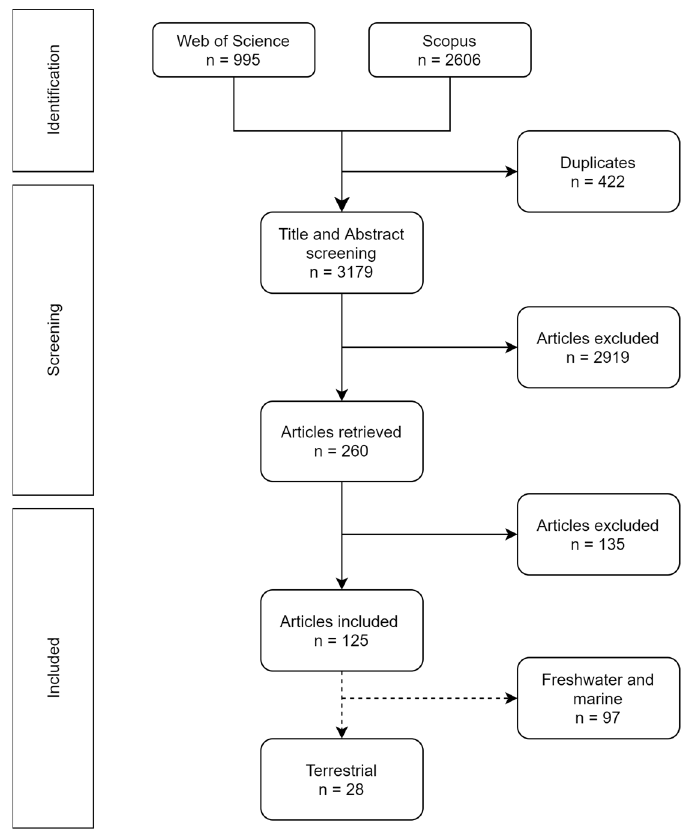
Figure 1. Flow diagram of the study selection process.